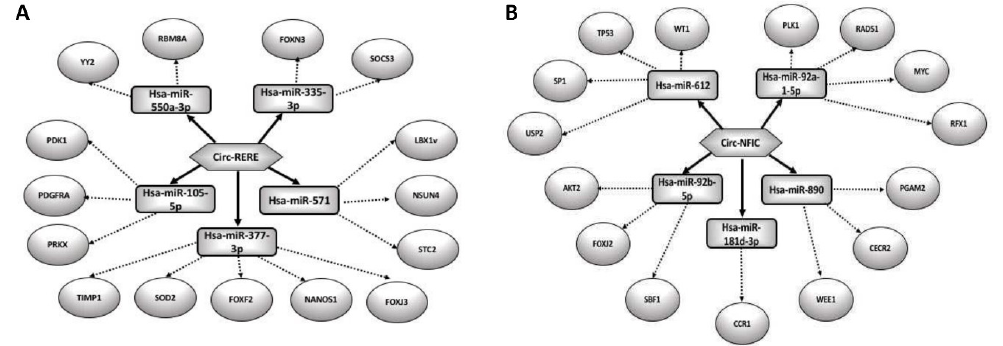
Figure 7. CircRNA-miRNA network analysis. Circ-RERE and circ-NFIC and their predicted miRNAs were selected to generate a network map involved in embryo development ( A ) and germ cell progression ( B ), respectively. The circRNA-miRNA network was constructed using bioinformatic online programs (starBase, circBase, TargetScan, miRBase, Cytoscape).